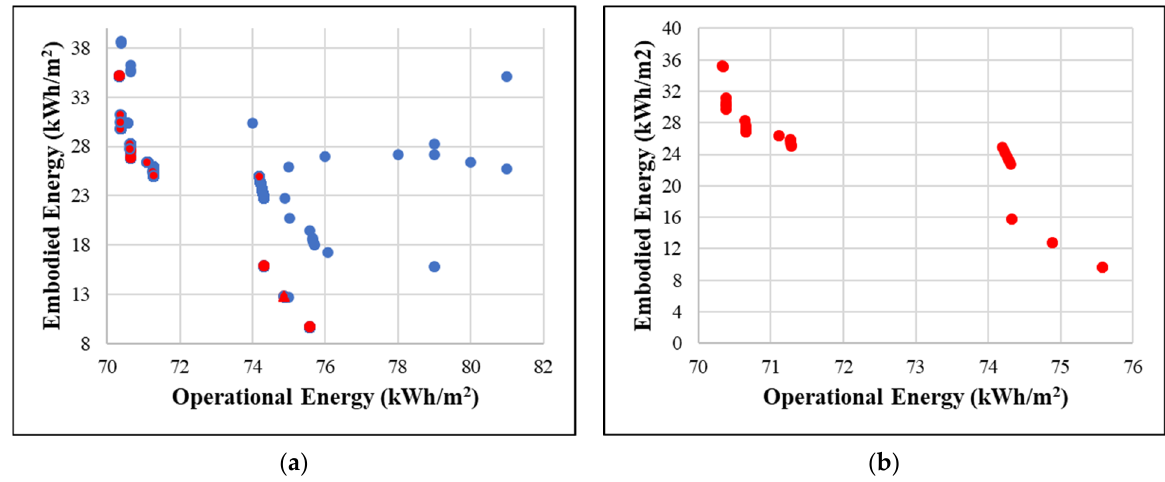
Figure 11. Scatterplot of operational energy use against embodied energy use (Abuja, Nigeria). ( a ) Entire solution space, ( b ) Pareto optimal solutions.